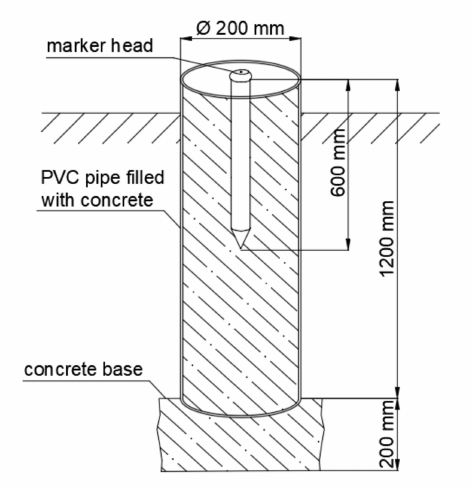
Figure 4. Scheme of control network points stabilisation.